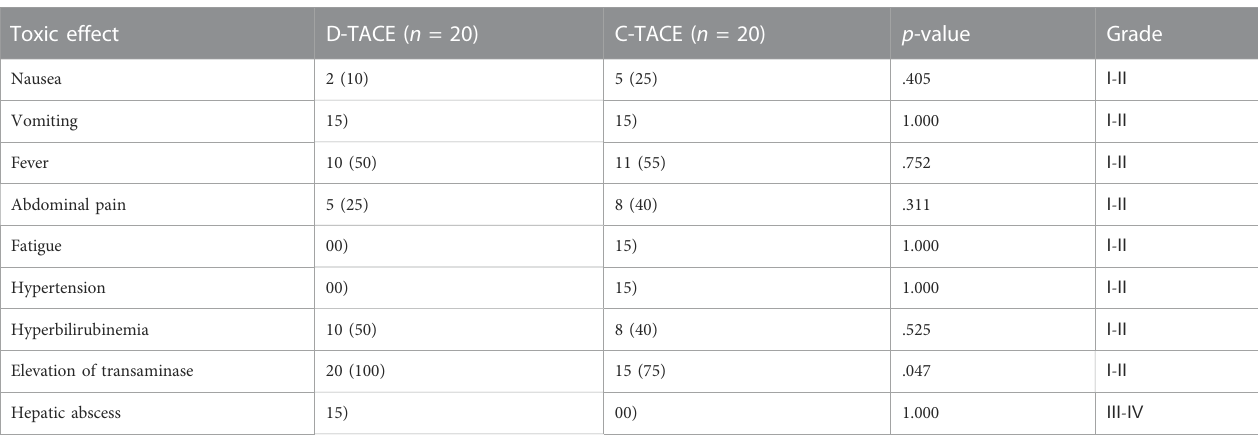
TABLE 3 Common toxic effects encountered after